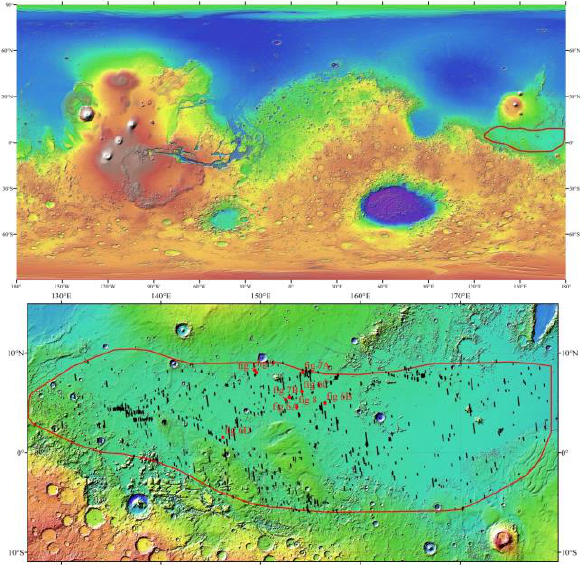
Figure 2. Locations of the study area and the footprints of the datasets used in the research. (A) Top panel, the location of the study area is represented by the red polygon. (B) Bottom panel, the footprints of the HiRISE images (black) used in the research. The locations of the subsequent images used in the paper are also labelled. Mars Orbiter Laser Altimeter (MOLA) data is the background